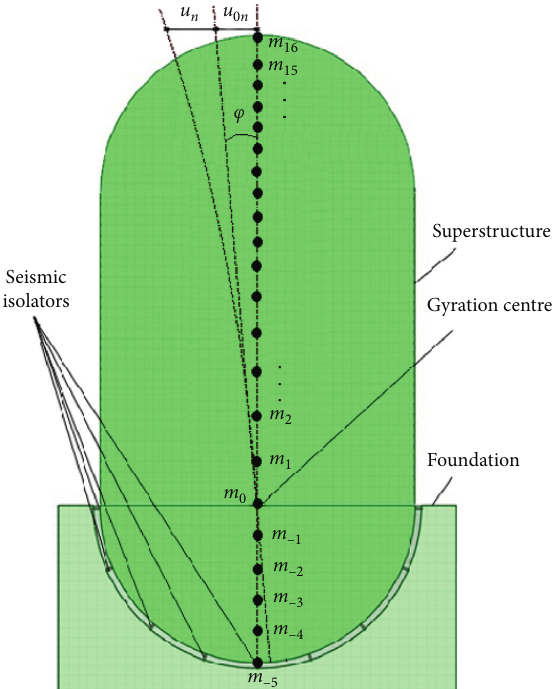
Figure 1: General working mechanism schema of the SSIS-NC